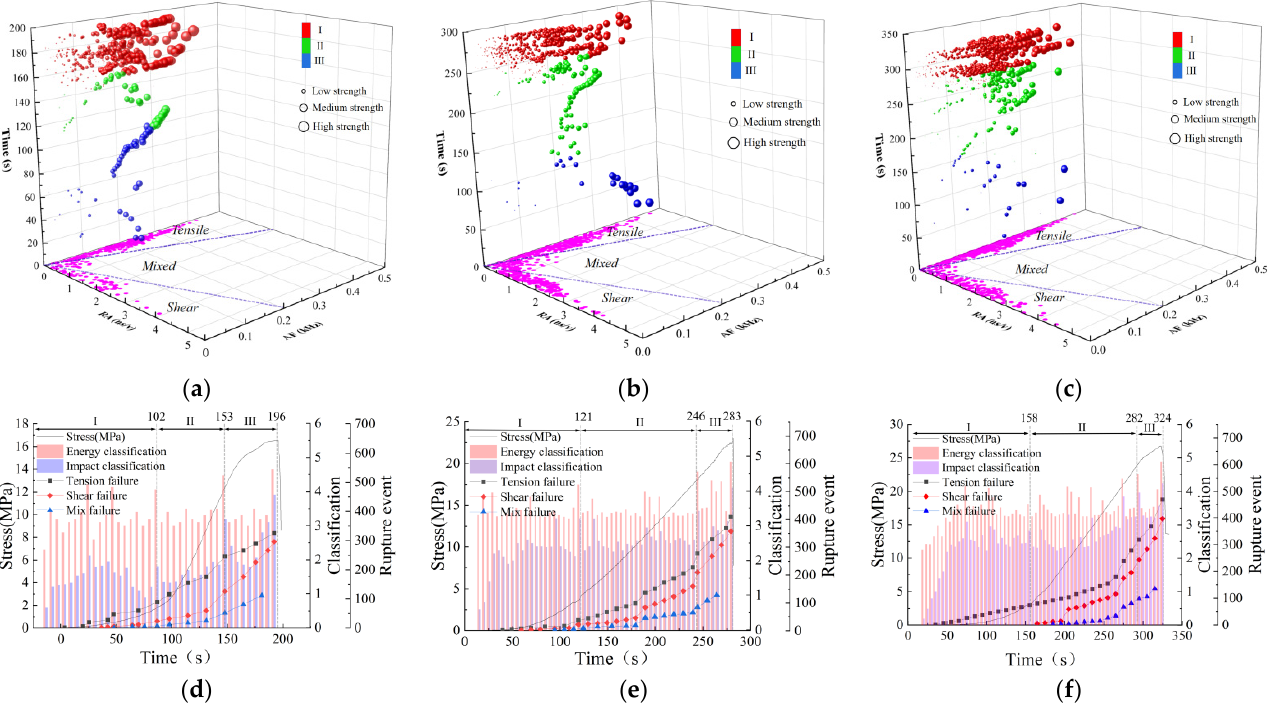
Figure 7. Fracture analysis of coal mass in different positions, ( a ) CSAS-1 RA–AF damage analysis; ( b ) CSAS-2 RA–AF damage analysis; ( c ) CSAS-3 RA–AF damage analysis; ( d ) CSAS-1 failure mode analysis; ( e ) CSAS-2 failure mode analysis; ( f ) CSAS-3 failure mode analysis.